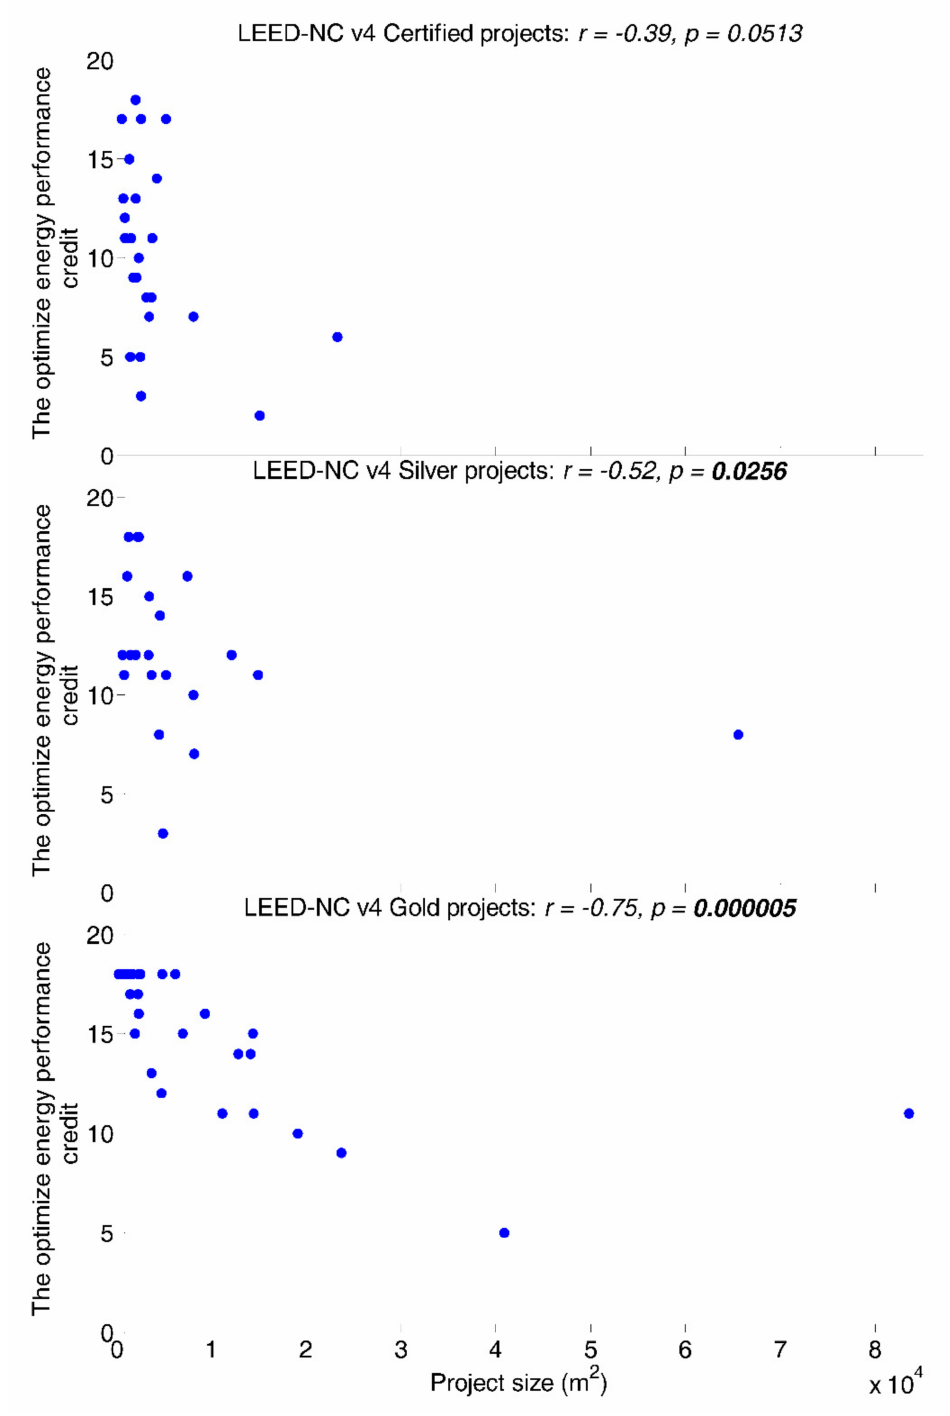
Figure 2. LEED-NC v4 office-type projects: optimized energy performance credit versus project